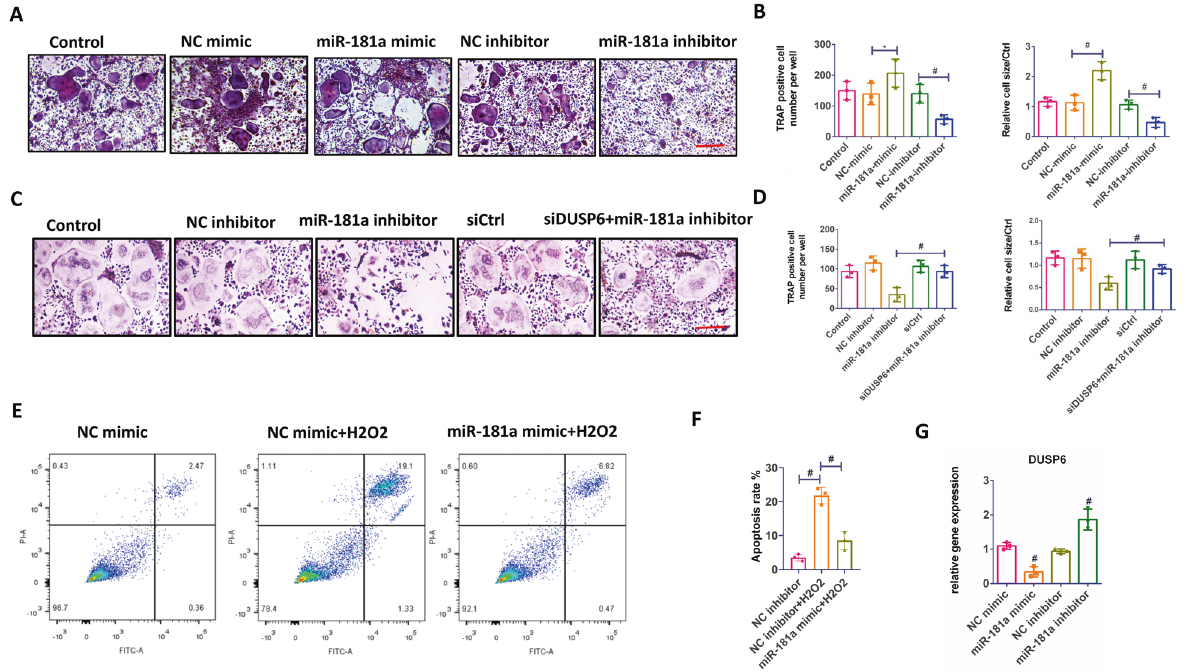
Fig. 6 MiR-181a accelerated the osteoclastogenesis in vitro. A TRAP staining was carried out to explore the function of miR-181a during the osteoclastogenesis. B Quantitative analysis was established. C BMMs were transfected with NC inhibitor and miR-181a inhibitor. DUSP6 expression was silenced using RNAi. TRAP staining were carried out to evaluate the osteoclast differentiation in the indicated groups. Original scale bars: 200 μ m. D Quantitative analysis were carried out to con fi rm the TRAP staining analysis. E The effect of miR- 181a on osteoclast apoptosis was calculated using Annexin V-FITC/PI kit by a fl ow cytometer. F The expression of DUSP6 in the indicated groups was analyzed using real-time PCR in RNAKL-induced osteoclastogenesis. Data in all bar graphs are expressed as mean ± SD ( n = 3). * P < 0.05, # P <